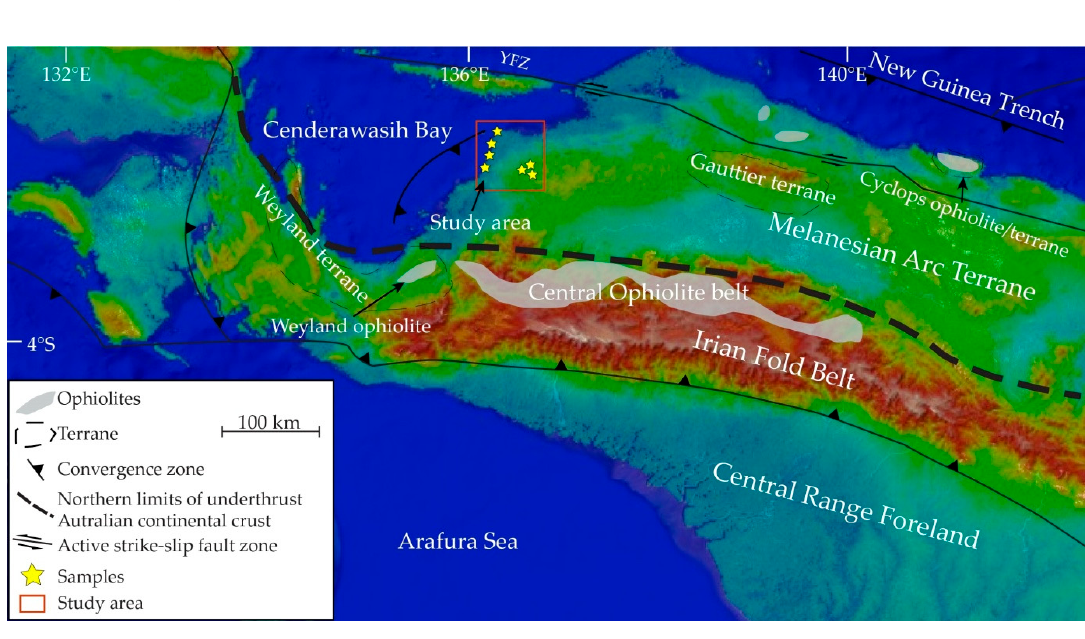
Figure 1. Map of New Guinea Island [31].